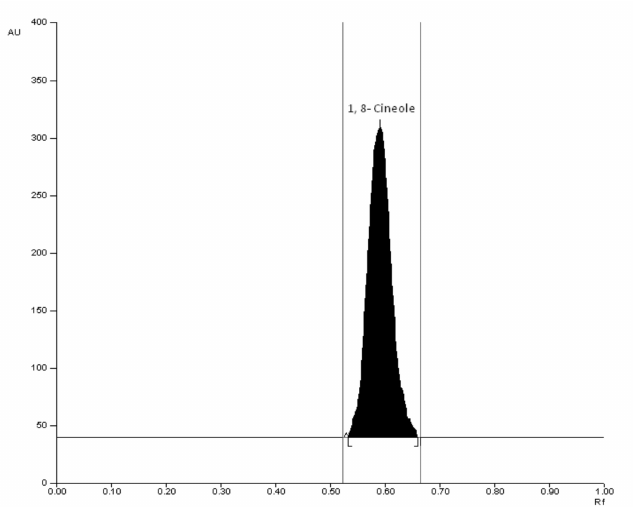
Figure 4. A typical chromatogram (R F = 0.59 ± 0.04) of 1,8-cineole (major constituent of NEO); mobile phase: toluene–ethyl acetate–formic acid (8.5:1.5:0.1, v/v/v